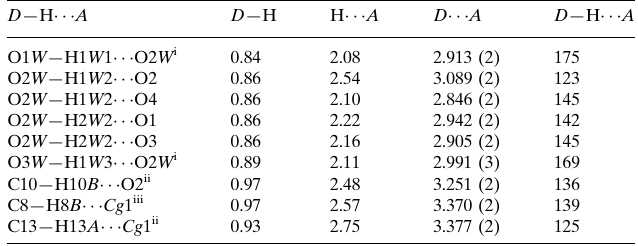
Hydrogen-bond geometry (A˚ , (cid:2) ). D —H (cid:1)(cid:1)(cid:1)